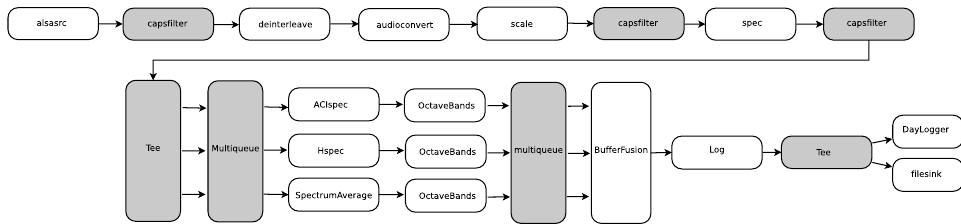
Figure 5. GStreamer pipeline for the computation of ecoacoustic indices and energy in octave